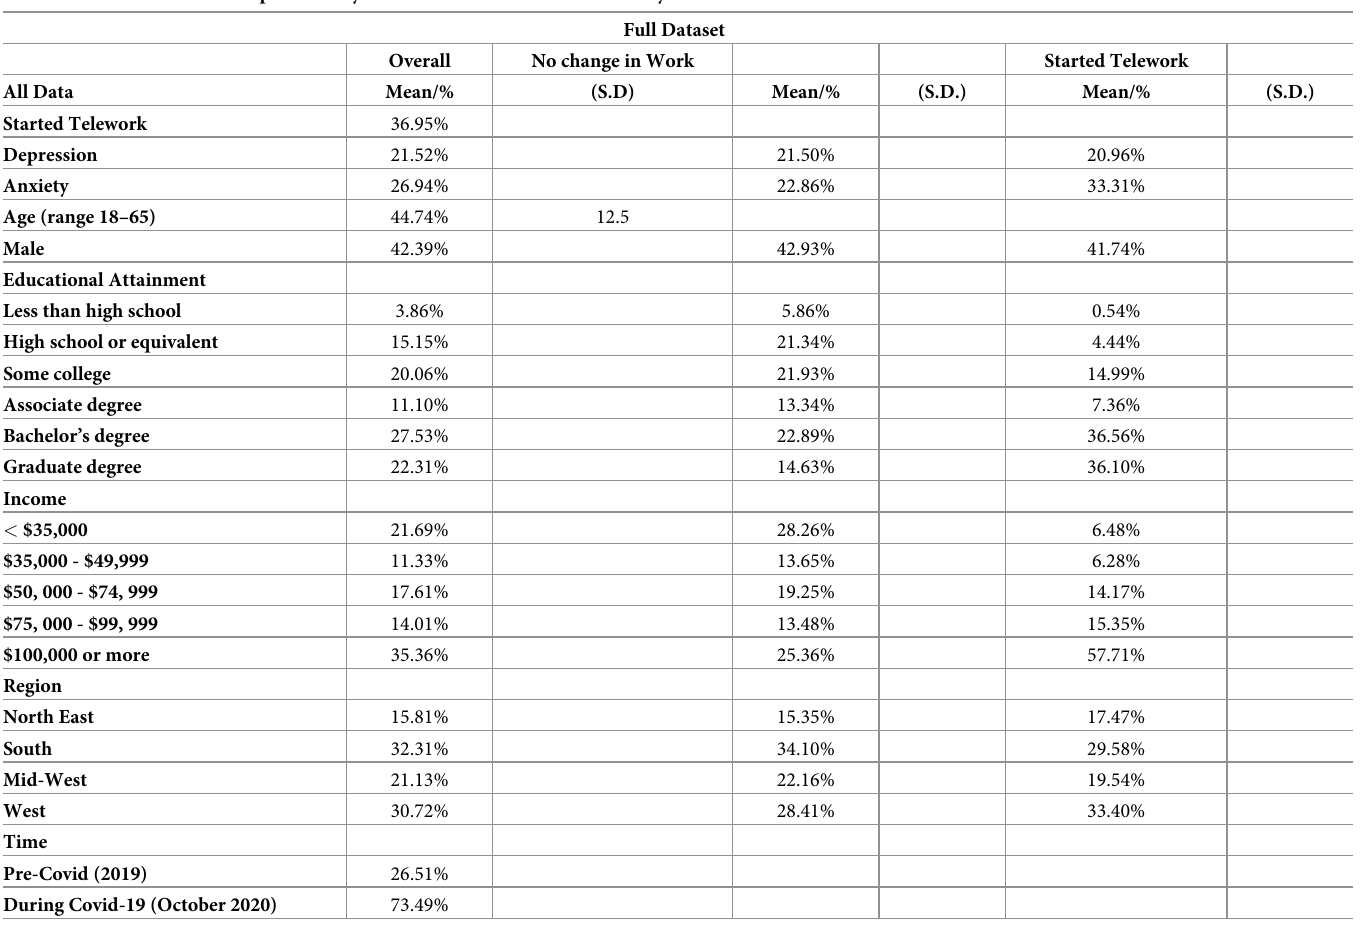
Table 3. Combined household pulse survey and national health interview